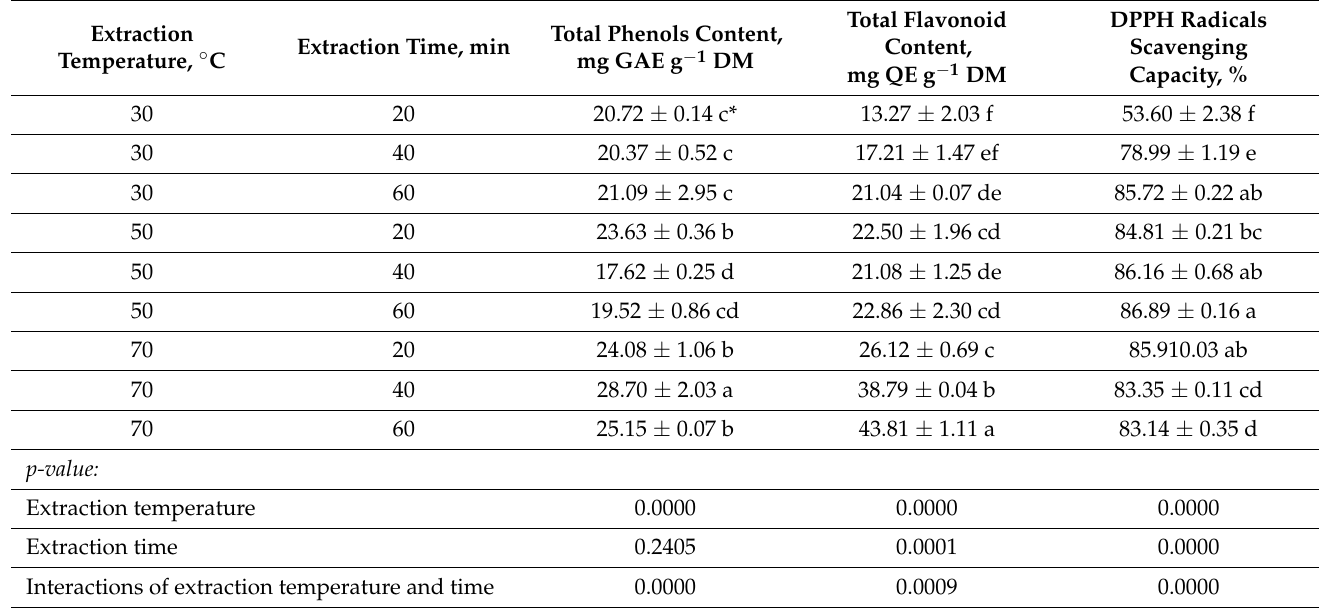
Table 3. Effect of extraction conditions on total content of phenols, flavonoids, and antioxidant activity of 96% methanol extract of stinging nettle ( Urtica dioica L.)